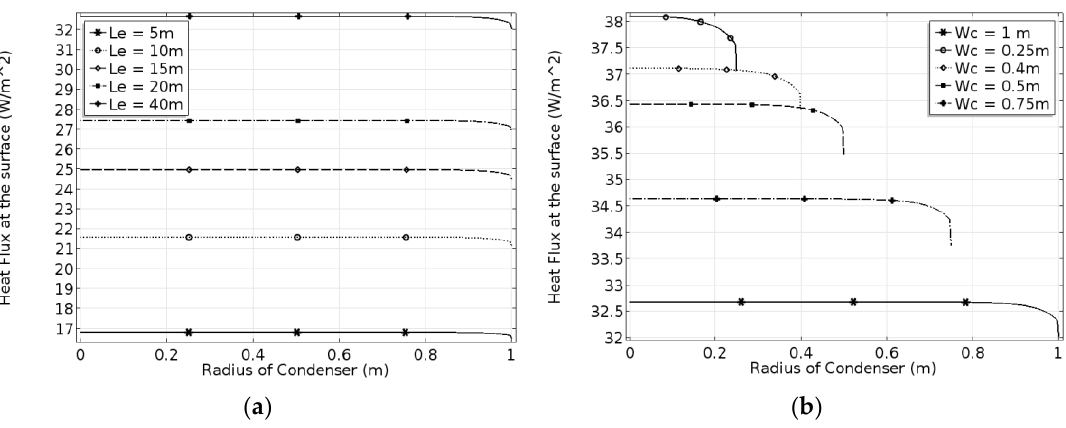
Figure 7. Parametric study for ( a ) evaporator length ( Le ) ( b ) Condenser radius ( Wc ).